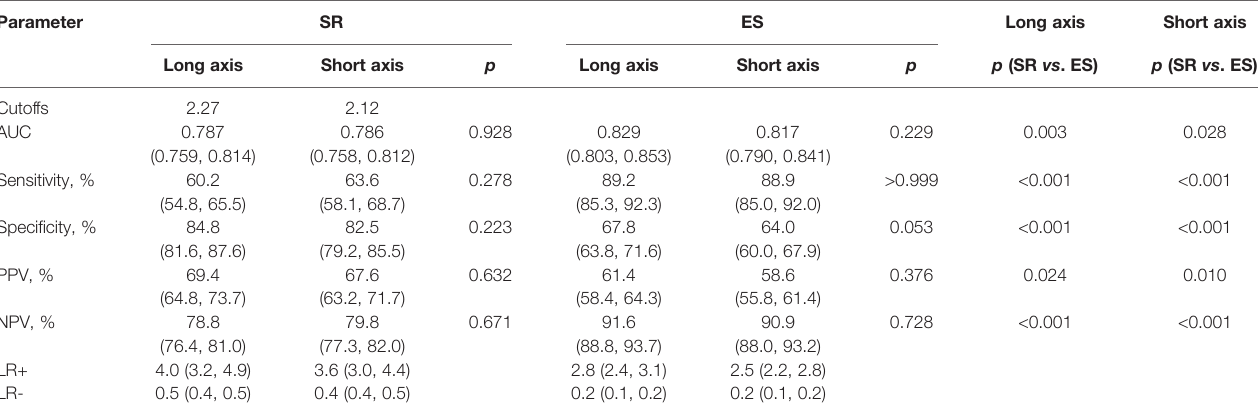
TABLE 4 | Comparison of the diagnostic performance of elasticity score and strain ratio. Parameter